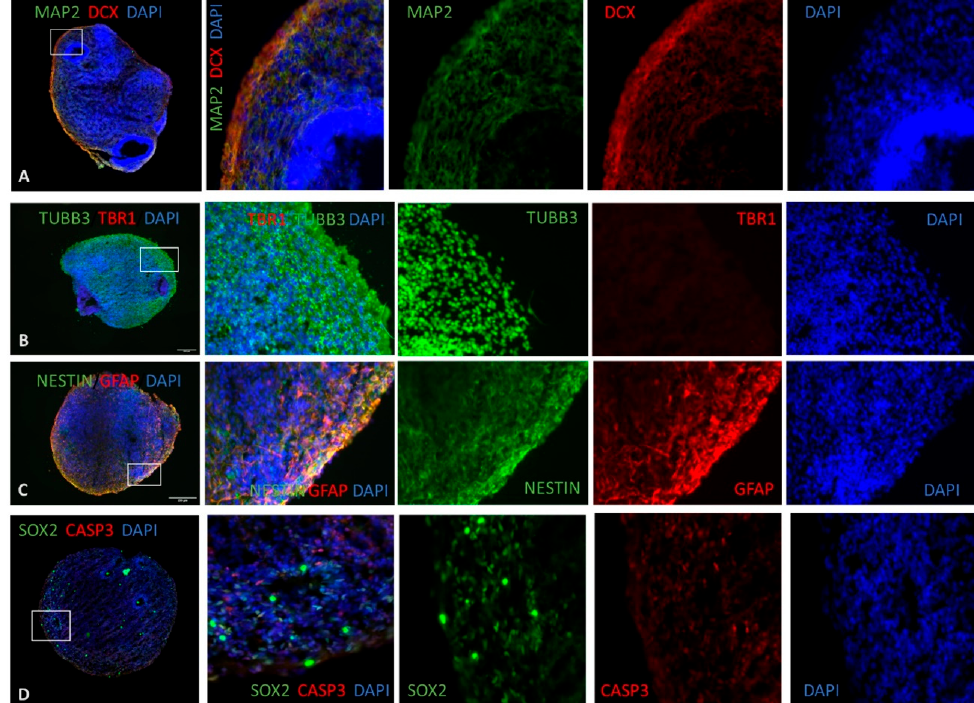
Figure 3. Differentiation of human cerebral organoids in vitro. Representative immunostaining of human cerebral organoids with 45 days post-differentiation, in cryosections with 10–15 µ m. Scale bars: 200 µ m. Nuclear staining with DAPI (blue). ( A ) Staining for the neuronal marker MAP2 (green) enlightens a superficial preplate, and for newborn neurons, marker doublecortin (DCX) (red). ( B ) Staining for cortical-layer neurons by tubulin beta 3 (TUBB3) (green) marker, showing a large cortical region. The pre-plate marker Tbr1 (red) for early-born neurons did not show any presence, thus revealing that early-born neurons were scarce and the brain organoids were mature. ( C ) Immunostaining of human cerebral organoids derived from iPSCs expressed for a neural stem cell marker (NESTIN) (green) at a low level and some glial fibrillary acidic protein (GFAP, human astrocytic marker) (red). ( D ) Immunostaining with neural progenitor cells (NPC) marker SOX2 for the ventricular zone (VZ) and apoptosis marker Caspase 3 (CASP3). Endothelial receptors, such as PECAM ( p ≤ 0.01), CD36 ( p ≤ 0.01), and Integrin α V β 3 ( p ≤ 0.0001), were over-expressed by P. falciparum 3D7 at 24 h of activation (Figure 2J–M). P. falciparum HB3 and Dd2 strain ( p ≤ 0.05) at 24 h. Overall, the results suggest that 24